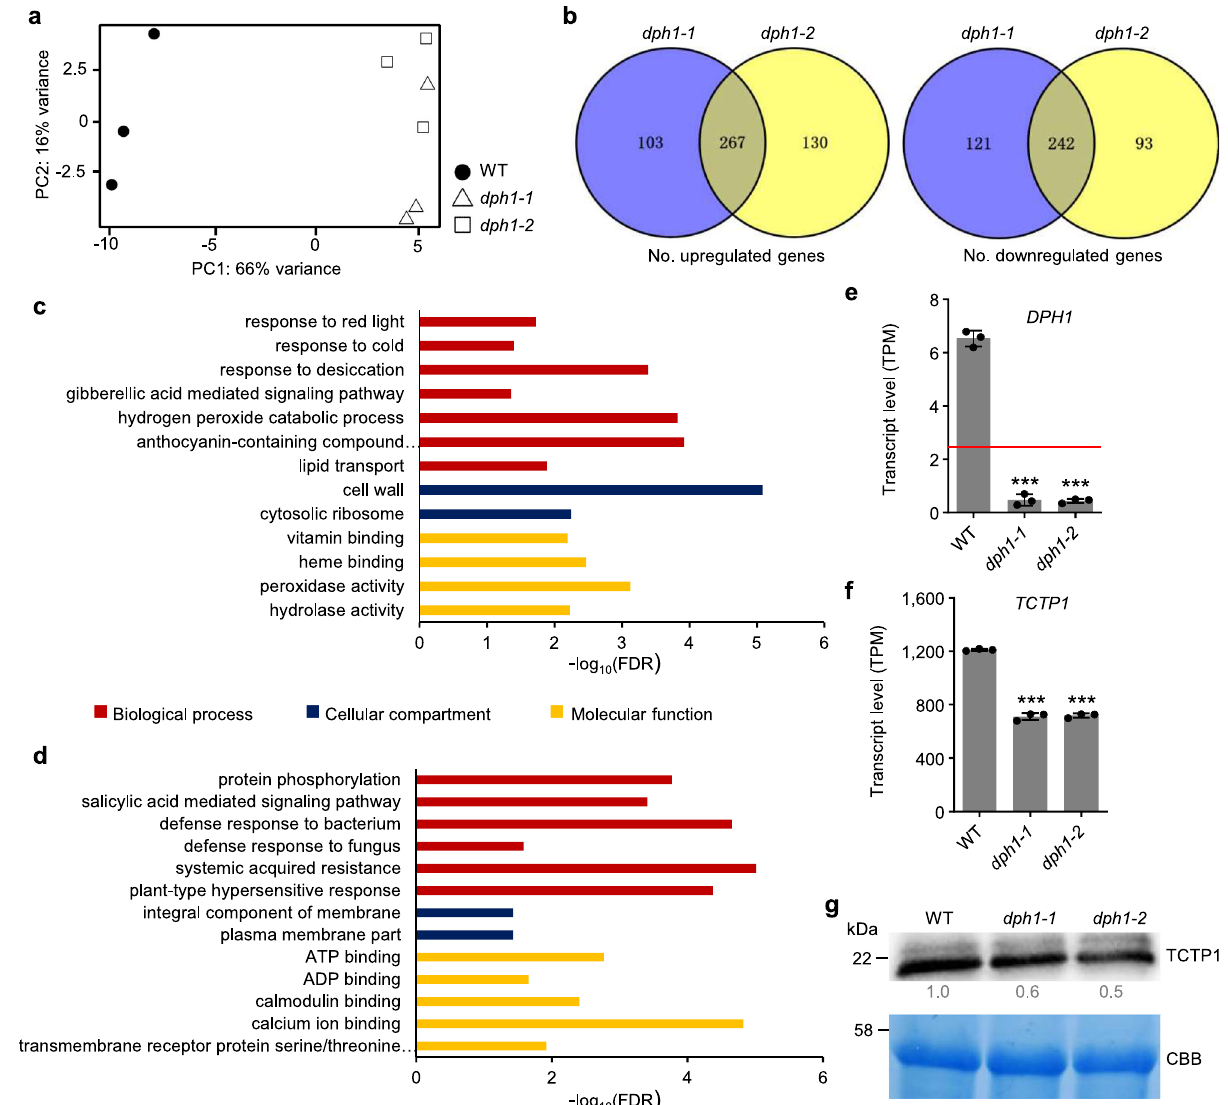
Fig. 4 Comparative transcriptomics of dph1 mutants and wild-type plants. a Principal Component Analysis of normalized transcriptome data (transcripts per kilobase million, TPM). b Venn diagrams showing transcripts present at higher (upregulated) and lower (downregulated) levels in dph1-1 and dph1-2 mutants, compared to the wild-type (WT). c , d Representative GO terms signi fi cantly enriched among genes of which transcript levels are upregulated ( c ) and downregulated ( d ) in both dph1-1 and dph1-2 mutants compared to WT (FDR < 0.05). e Normalized transcript levels of DPH1 . Red horizontal line marks threshold TPM of 2.46 used to fi lter out non-expressed genes. f , g TPM of TCTP1 ( f ) and TCTP1 protein levels determined by immunoblot using an anti-TCTP1 antibody or stained with Coomassie Brilliant Blue (CBB) as a loading control; numbers are band intensities relative to those in WT ( g ). Data are mean ± s.d. ( e , f ), n = 3 indepe n dent experiments, with leaves sampled from 4-week-old soil-grown plants ( a – g ). Signi fi cant differences from WT: *** P < 0.001 (one-way ANOVA, Tukey ’ s